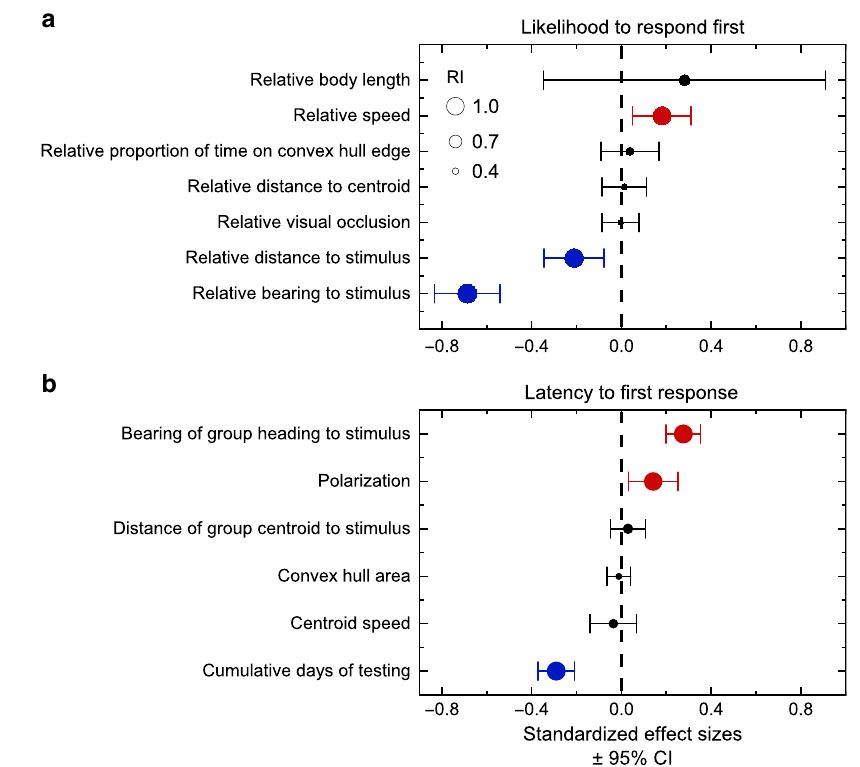
Fig. 1 Predictors of responsiveness to the stimulus. Model averaged coef fi cient estimates from candidate generalized linear mixed models (GLMMs) to examine the predictors of ( a ) the likelihood of fi rst response and ( b ) the latency to fi rst respond ( n = 428 presentations). Centres of points indicate the standardized model averaged effect sizes for each of the parameters (scaled, mean = 0, SD = 1) and error bars indicate 95% con fi dence intervals (CI) of effect sizes based on the 95% candidate set of models (Supplementary Tables 2 and 4). Sizes of points represent the relative importance (RI) of each parameter: the sum of the Akaike weights over the models in which that parameter appears (based on the complete candidate set of models). Parameters that co-vary positively with the response variable are coloured red, whereas those that co-vary negatively are coloured